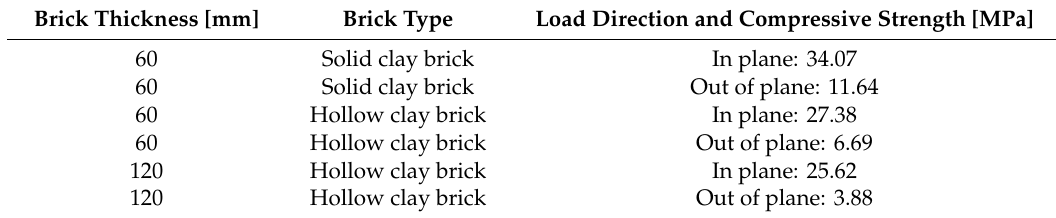
Table 1. Mechanical characteristics of commercial solid and clay bricks.